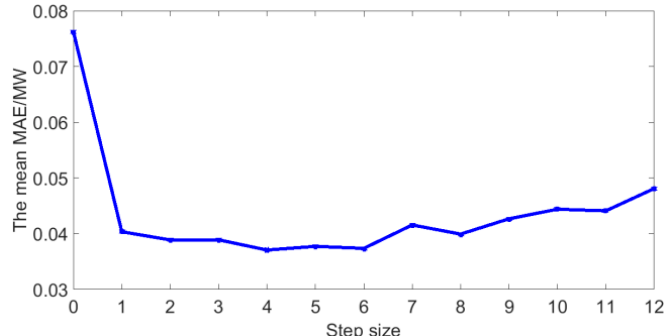
Figure 7. The mean absolute error (MAE) of photovoltaic power in different step size.